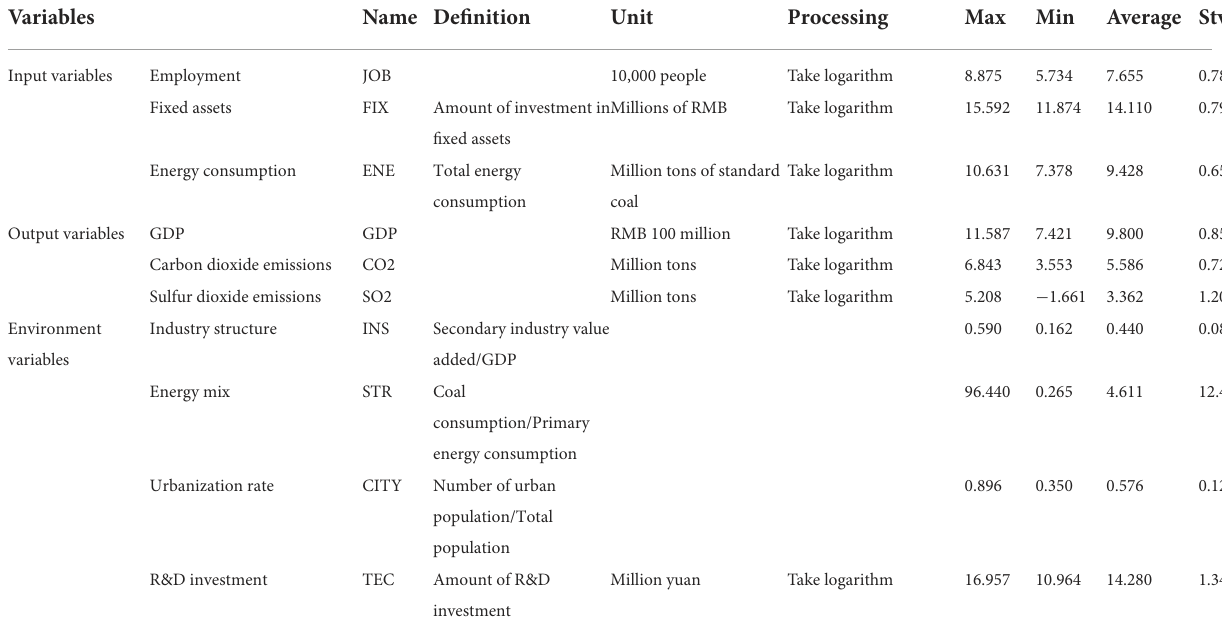
TABLE 1 Variable settings and descriptive